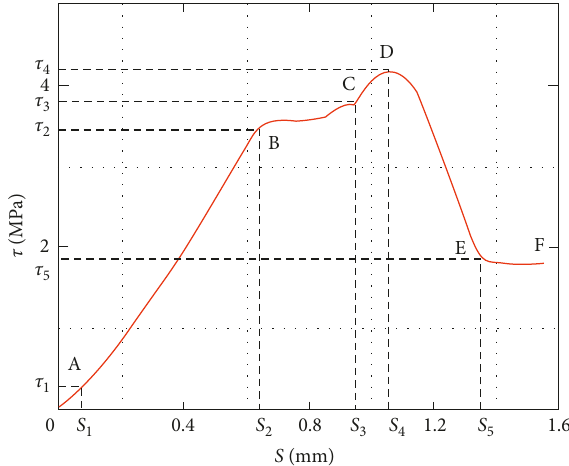
Figure 4: τ − S curves of the specimen.